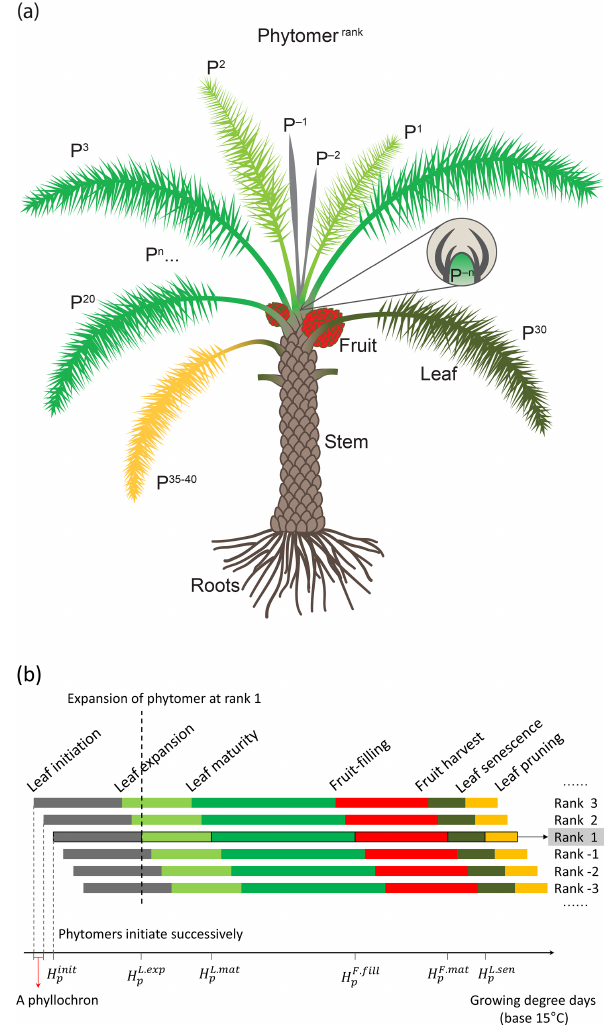
Figure 1. (a) New sub-canopy phytomer structure of CLM-Palm. P 1 to P n indicate expanded phytomers and P − 1 to P − n at the top indicate unexpanded phytomers packed in the bud. Each phytomer has its own phenology, represented by different colors correspond- ing to (b) the phytomer phenology: from initiation to leaf expansion, to leaf maturity, to fruit-fill, to harvest, to senescence and to prun- ing. Phytomers initiate successively according to the phyllochron (the period in heat unit between initiations of two subsequent phy- tomers). Detailed phenology description is in the